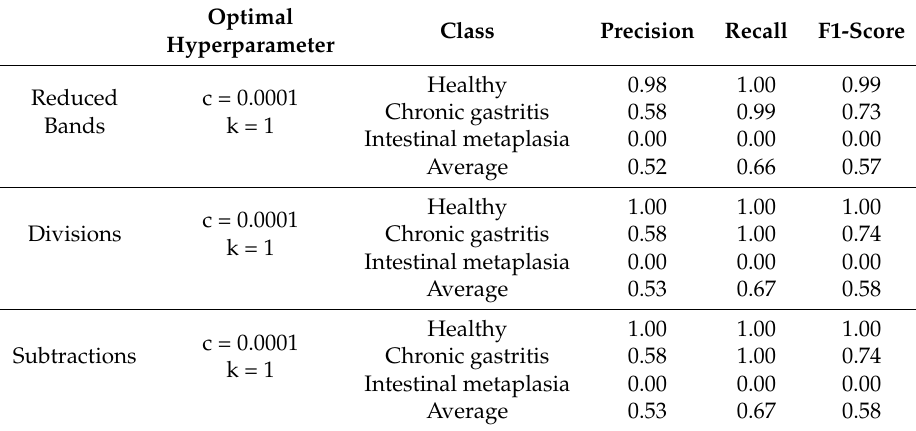
Table 2. Classification results with the VIS camera.